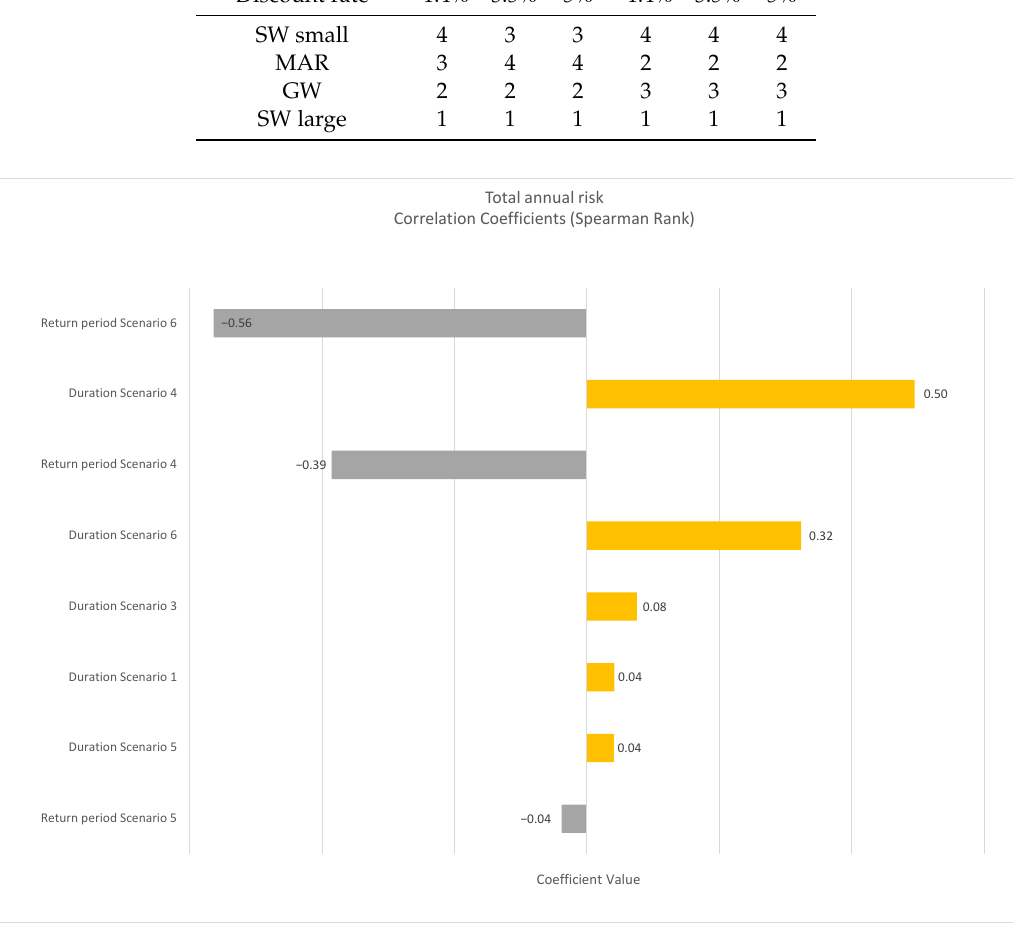
Figure 6. Correlation coe ffi cients (Spearman rank) of the eight most strongly correlated input variables for the total annual